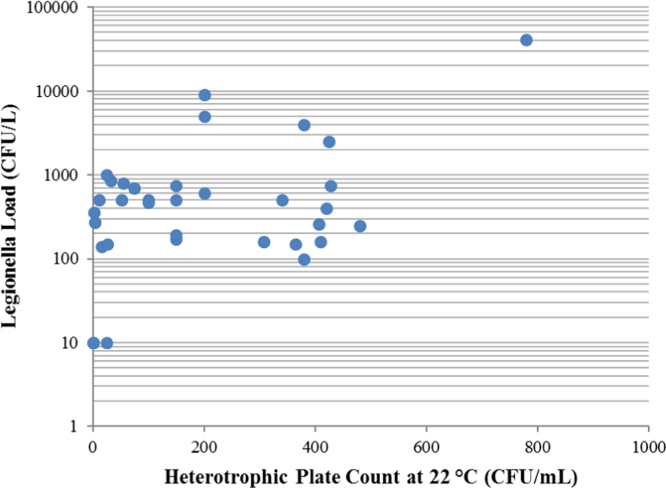
Scatter Plot showing the relationship between Legionella load (CFU/L) and the Heterotrophic Plate Count at 22 °C (CFU/mL). Pearsons’ r = 0.5458; r2 = 0.2979. 2 samples not included in the construction of the plot because the HPC 22 °C was over 800 CFU/mL, so that it couldn’t be determined with accuracy.